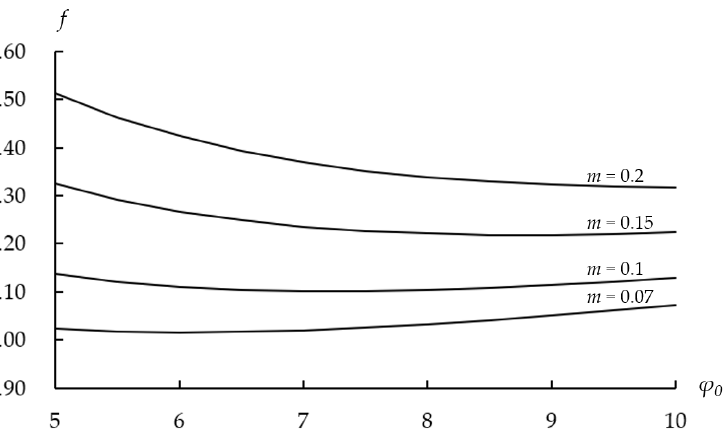
= 1.1 and = 1.1 and sev- = 1.1 and sev- = 1.1 and sev- R 2 (cid:3019) (cid:3118) (cid:3019) (cid:3118) (cid:3019) (cid:3118)